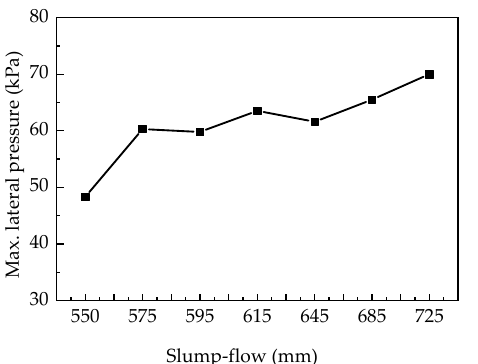
Figure 3. The change in peak lateral pressure with the slump-flow of fresh SCC.